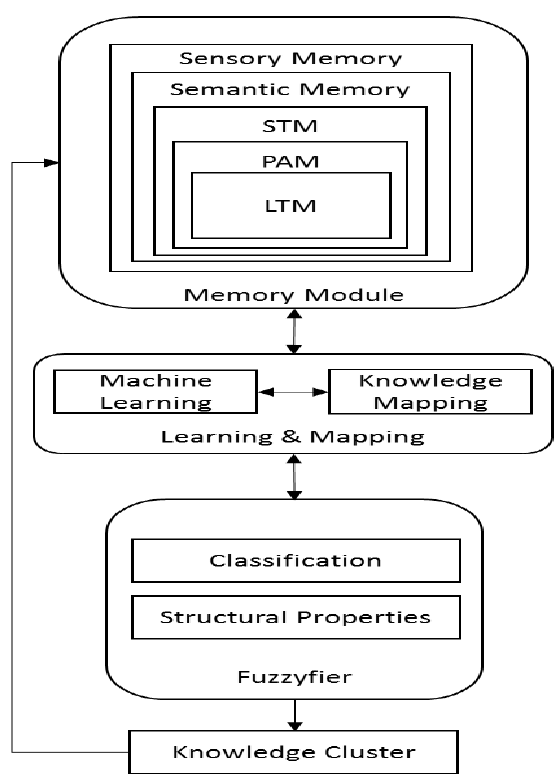
Figure 1. Proposed Model Heterogeneous Knowledge Classification System